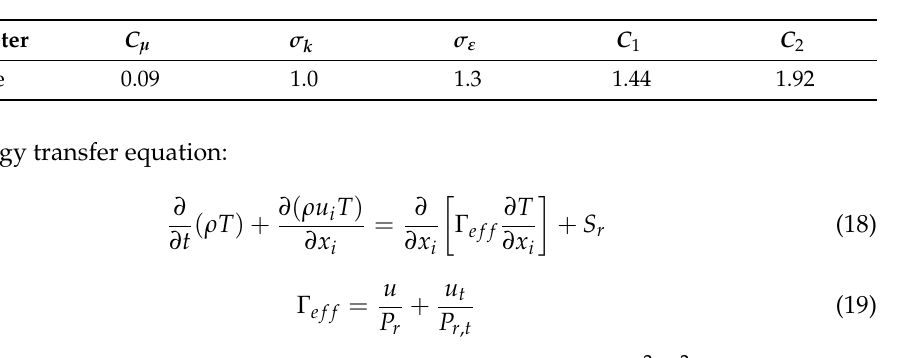
Table 2. The constants of the k - ε